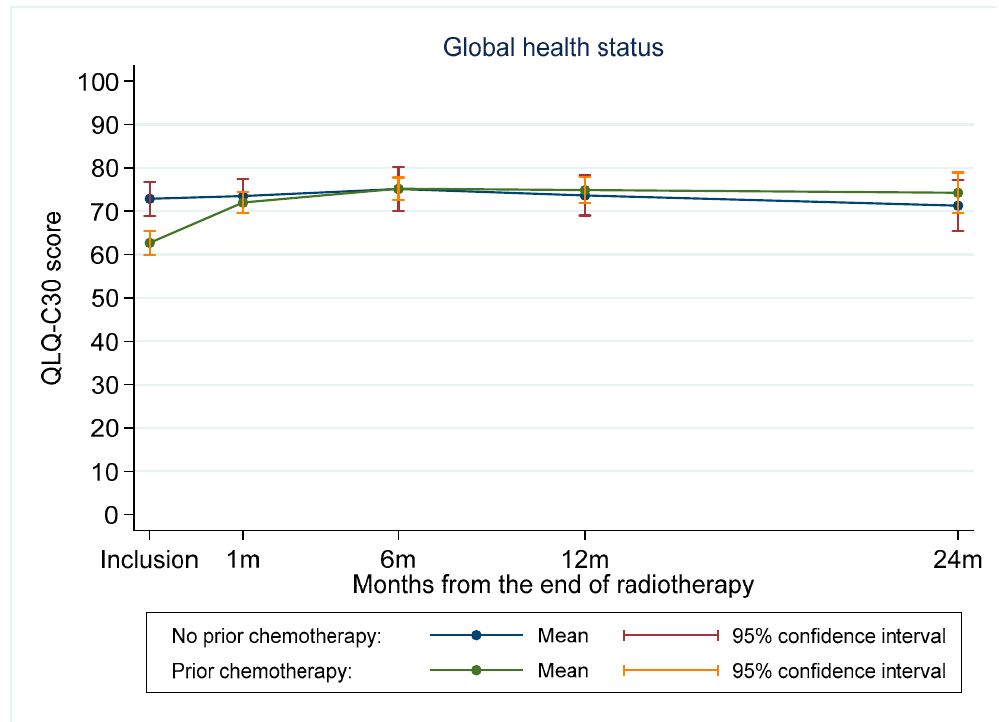
Figure 1. Evolution of quality of life global health score over time according to chemotherapy status (breast-conserving surgery).